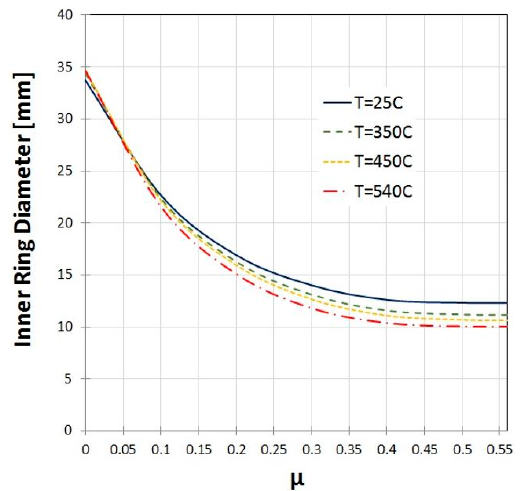
Figure 9. Dependence of the minimum (middle height) inner diameter on μ for specimens with a ram velocity of 350 mm/min at various temperatures.